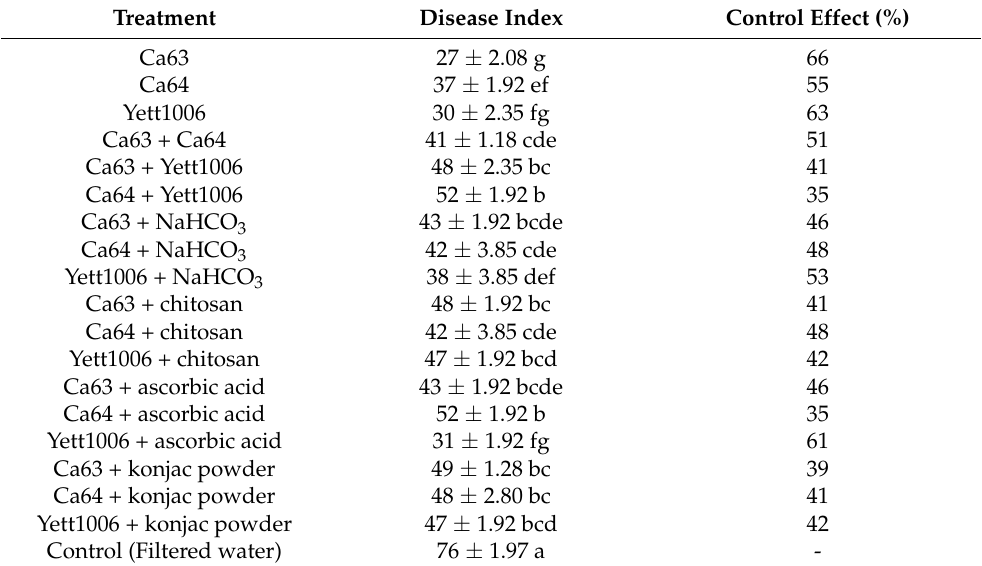
Table 5. Biocontrol effect of three strains and their different combinations on snap beans not inocu- lated with B. cinerea .